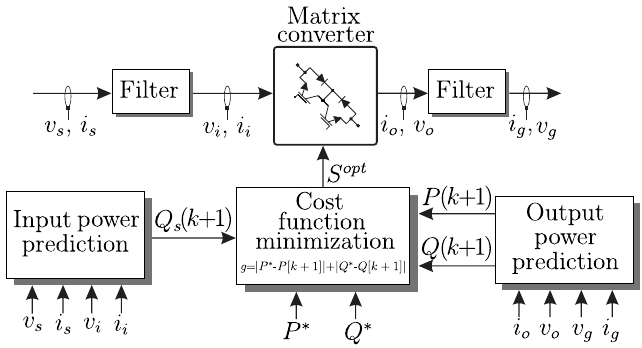
Figure 13. Predictive power control block